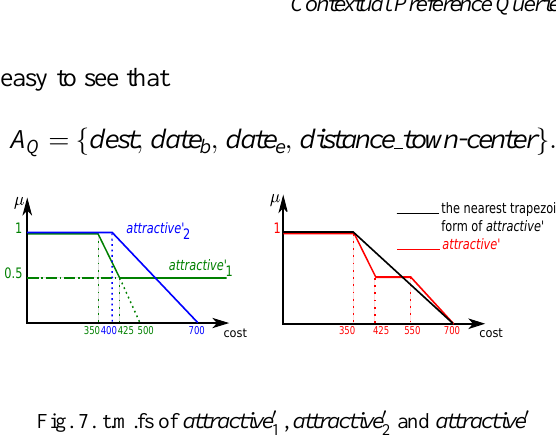
Fig. 7. t.m.fs of attractive ′ Algorithm 1 yields CP Q = { CP 1 , CP 2 , CP 4 } .